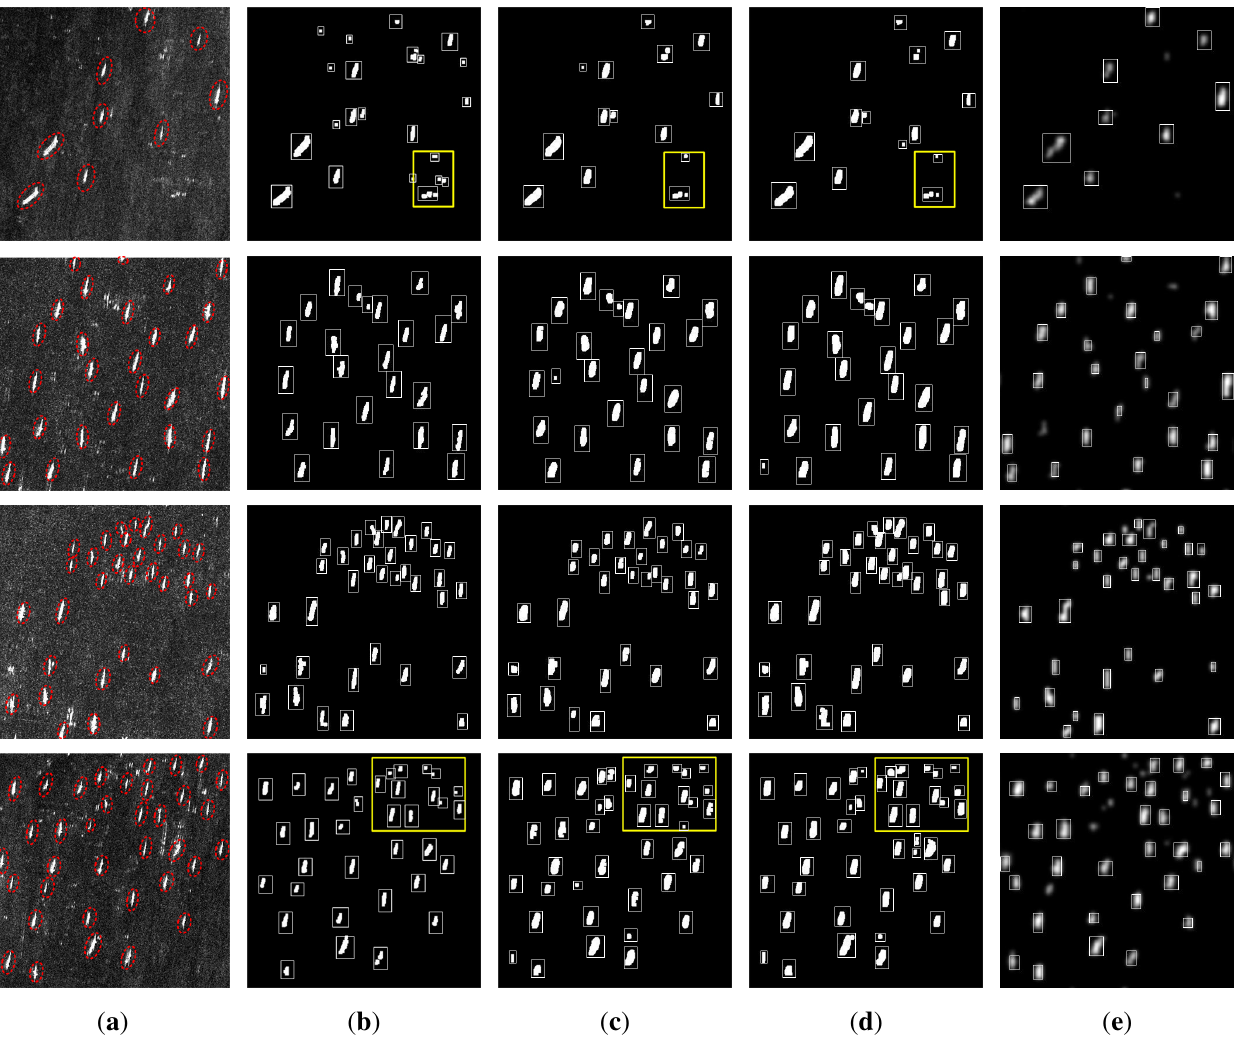
Results of ship target detection for SAR images with a complex scene by different algorithms. ( a ) Original SAR image with ship targets marked by red ovals. ( b – d ) The results of Nakagami-CFAR, Weibull-CFAR and G 0 -CFAR, respectively, with detected objects marked in white boxes. ( e ) The results of the proposed